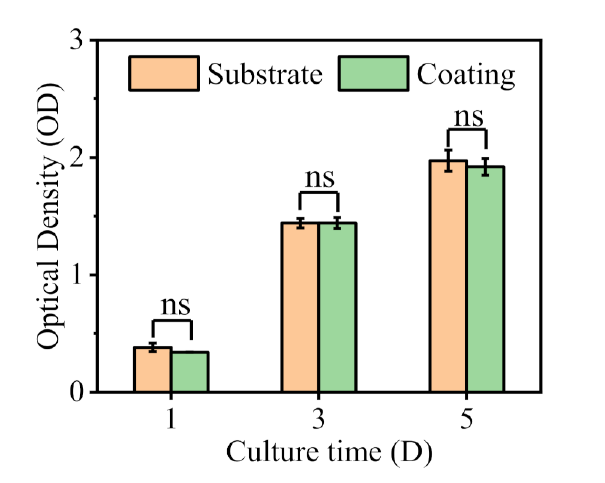
Figure 9. Quantitative statistics of active MG-63 cells after 1, 3, and 5 days of culture on the surface of the substrate and coating (ns stands for no significant